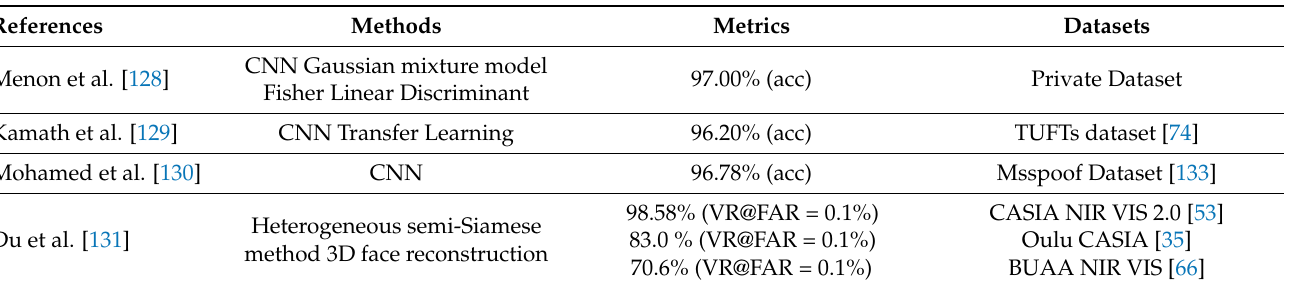
Table 5. Comparison of results on real-word